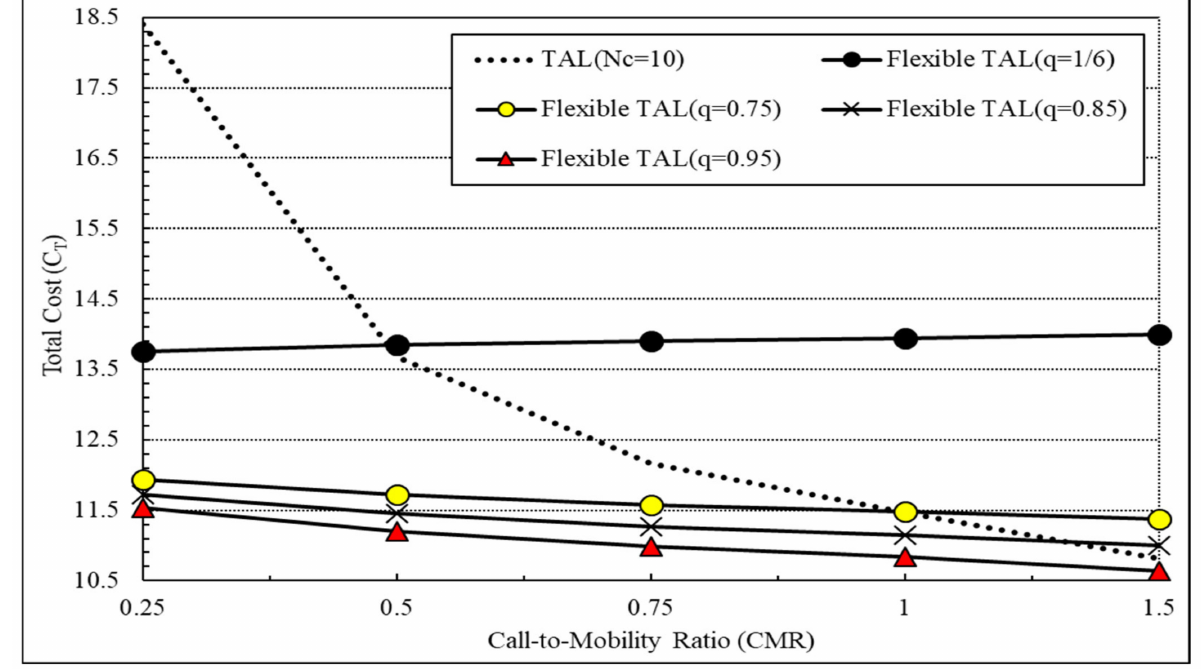
Figure 7. Total cost versus CMR and q (rural case).